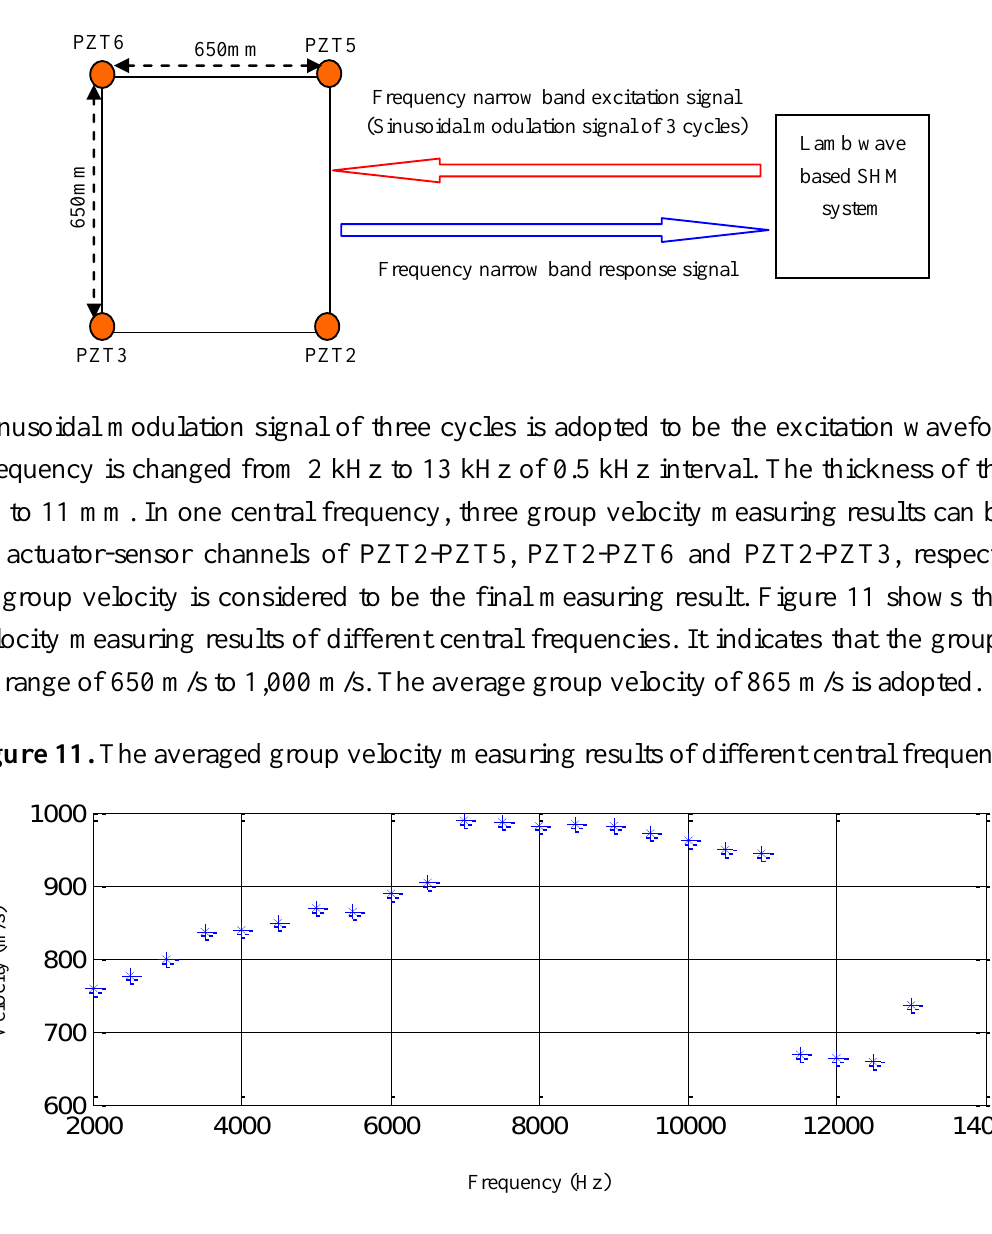
Figure 10. Experimental setup of group velocity measuring.